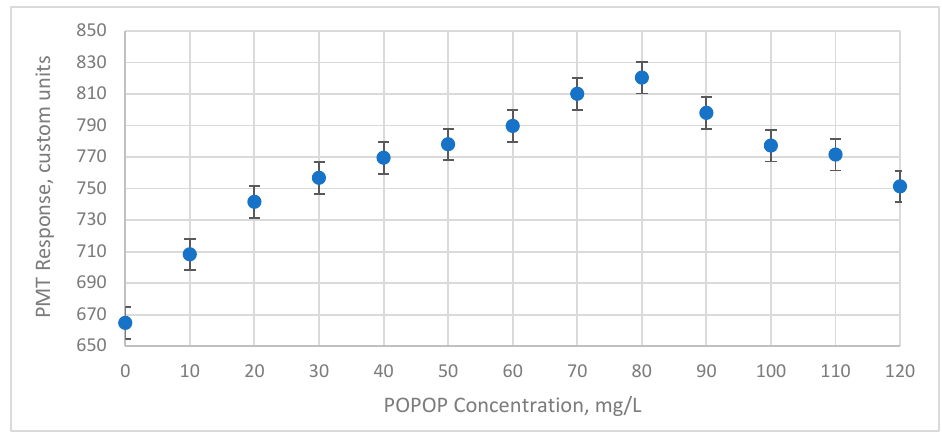
Figure 7. FEU-115 PMT response for different POPOP concentrations in a 10 g/L PPO scintillator.